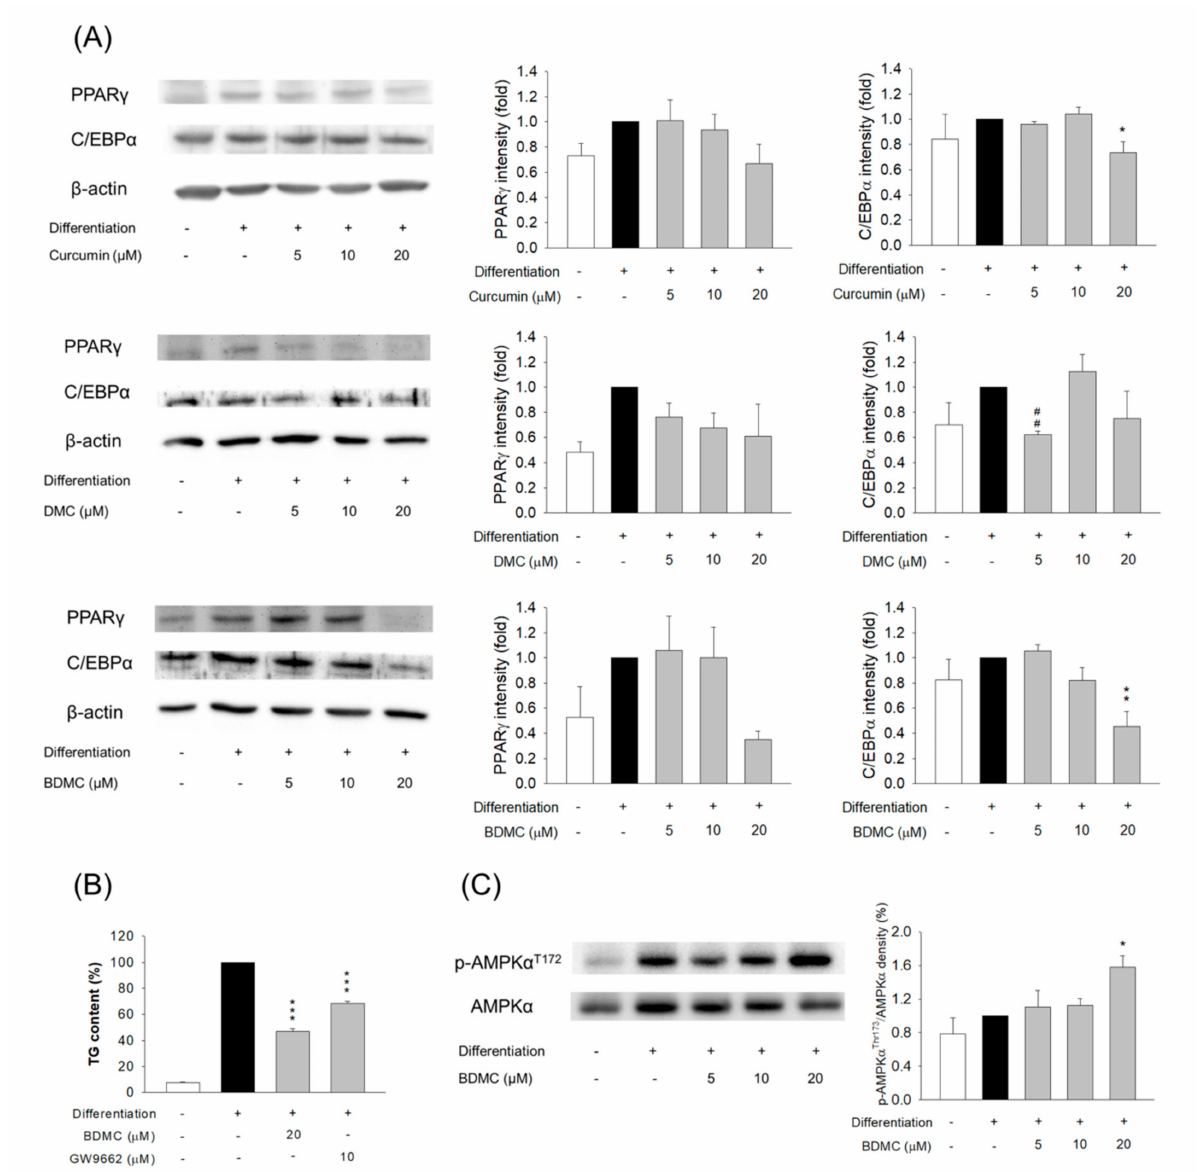
Figure 4. The effect of curcuminoids on transcription factors of 3T3-L1 cells. ( A ) The protein expression of PPAR γ and C/EBP α after treatment of curcuminoids at 0 − 20 µ M; ( B ) the intracellular TG content of 3T3-L1 cells after the treatment of BDMC and/or GW9662; and ( C ) the protein expression and AMPK α after treatment of BDMC at 0 − 20 µ M. All data are presented as the mean of three experiments ± S.E.M. *** p < 0.001; ** p < 0.01; * p < 0.05 as compared to the differentiated control group. ## p < 0.01 as compared to the curcumin-treated group at the same